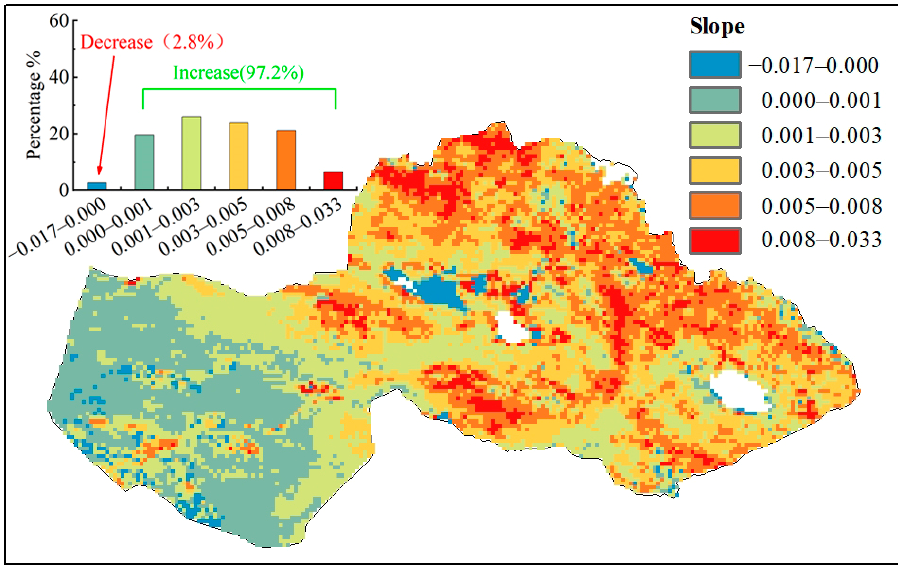
Figure 5. Trends of the pixel growing season NDVI with years from 2001 to 2020.